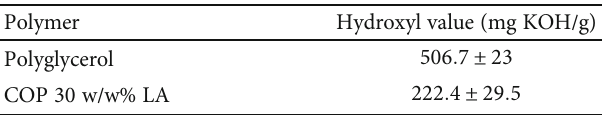
Table 3: Hydroxyl values of synthesized materials according to ASTM D4274-16